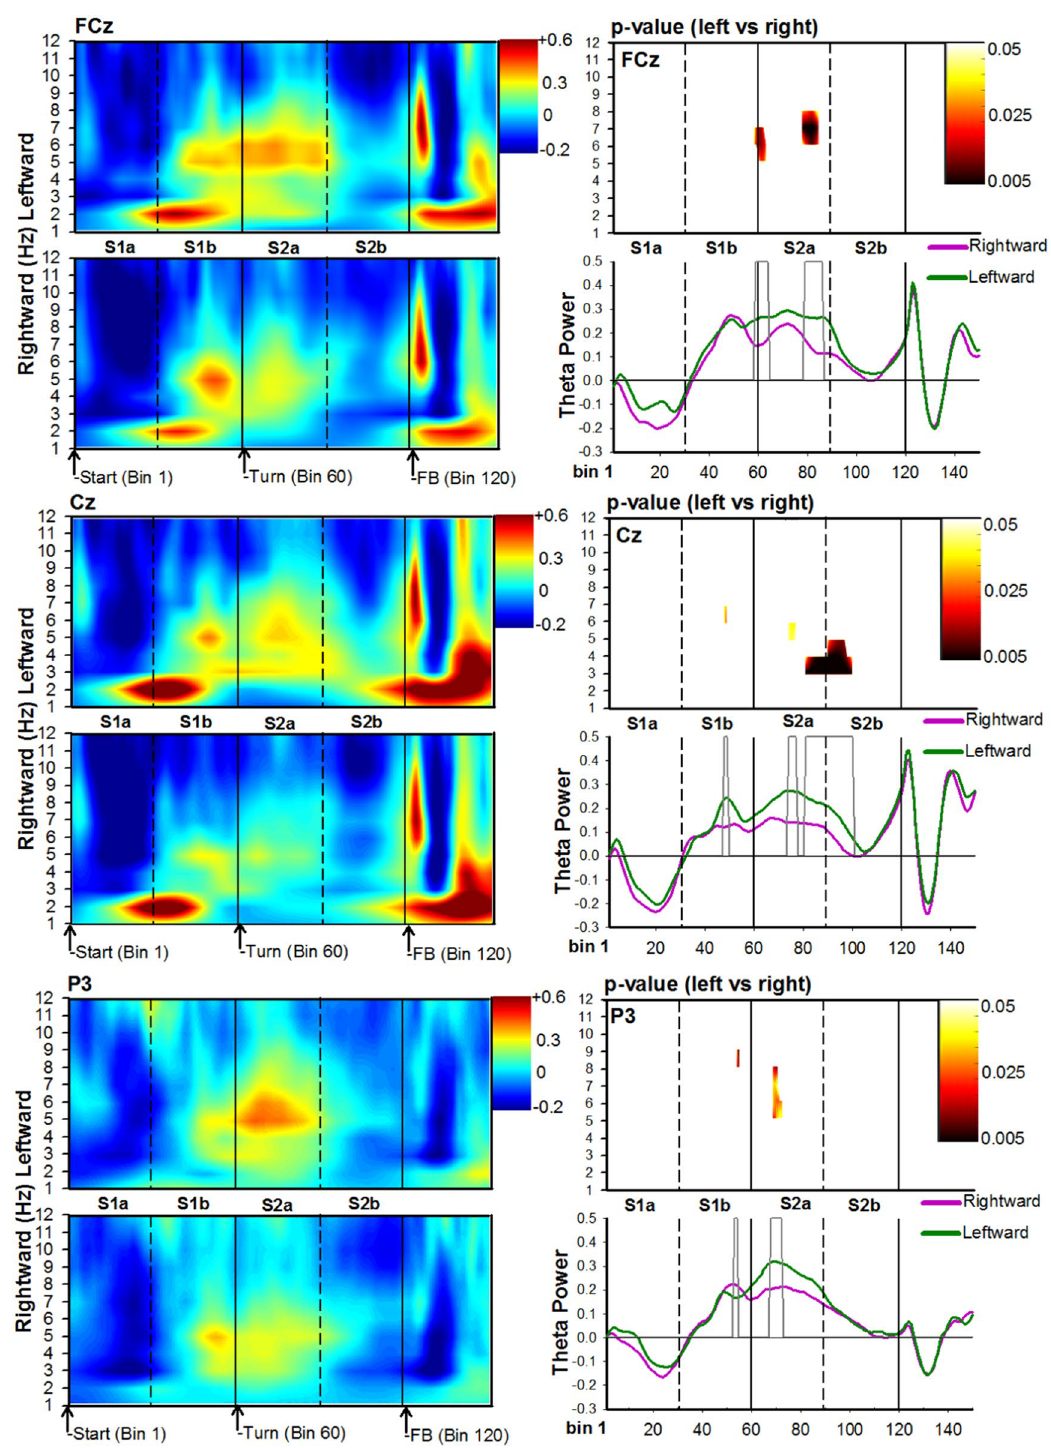
Figure 4. Time–frequency analysis associated with maze trajectories. For each channel location, FCz (top), Cz (middle), and P3 (bottom), panels depict time–frequency power maps (left panels), p-value maps (right-top panel), and theta time-course (right- bottom panel) for the leftward (green solid lines) and rightward (purple solid lines) conditions. The X-axis represents Bin location and maze subregion. The Y-axis for power and p-value maps represents frequency ranges from 0 to 12 Hz, and the Y-axis for the theta time-course represents a change in power . For all conditions, Bin 0 represents the start of the trial. The color bar for time–frequency plots represents the power of the oscillations depicting greater activity in warm colors. The heat-maps (left-top panel) represents the p-values (range 0.05 to 0.005) comparing leftward vs rightward trajectories. In particular, paired comparisons of data used to generate each grand averaged heat-map were calculated using paired-samples t-tests. The alpha value was set at 0.05 for each t-test conducted. However, to provide partial control for Type I error inflation, at least two consecutive significant comparisons around the target value were required before a specific value was portrayed on the graph 45 . The grey bars depicted in the theta-time course maps represent significant Bins identified in the